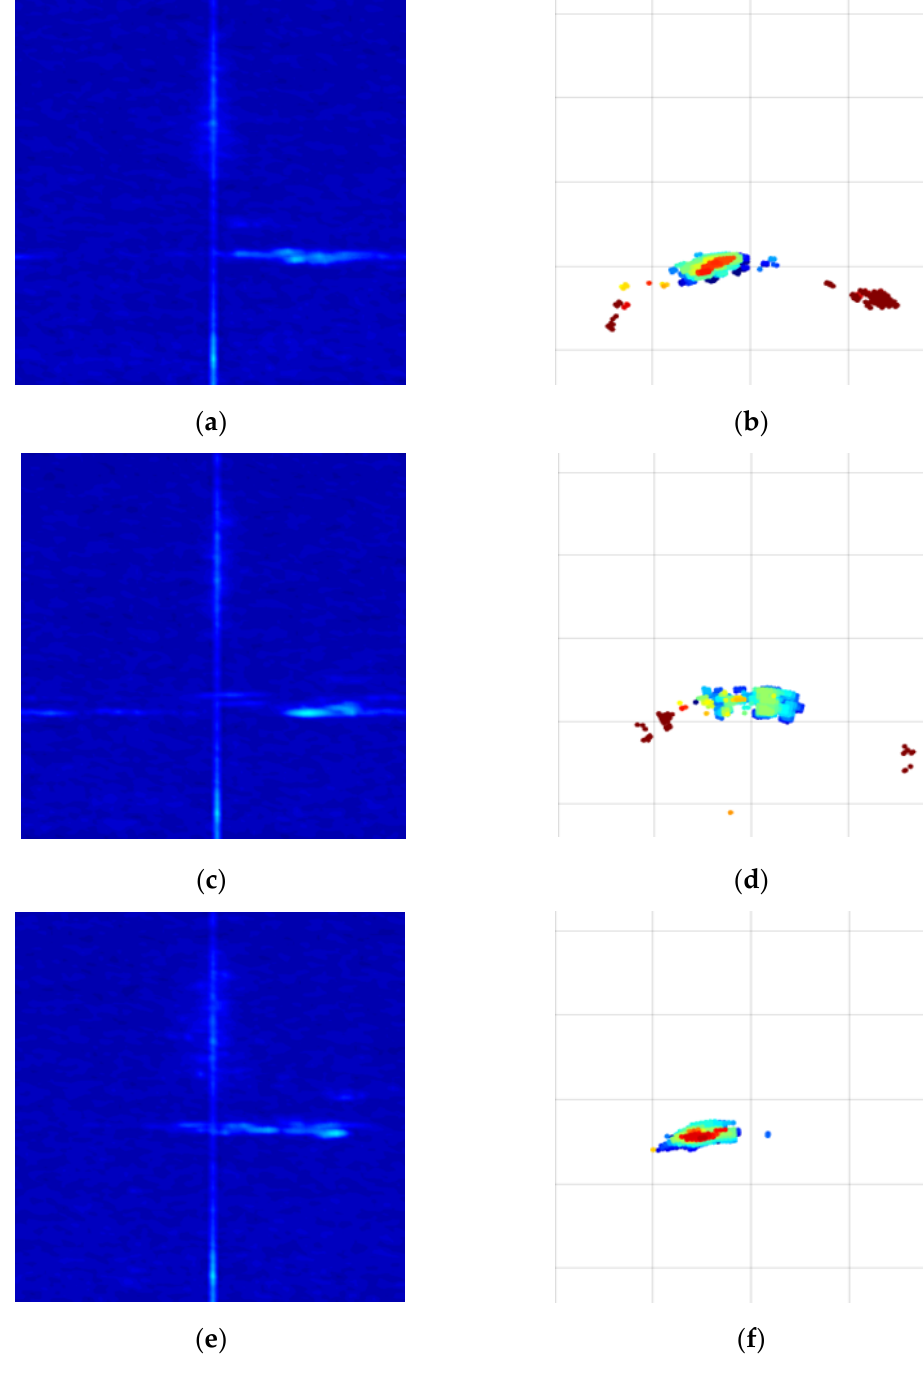
Figure 6. Range–Doppler map and point cloud map when a person moves: ( a ) range–Doppler map when moving diagonally; ( b ) point cloud map when moving diagonally; ( c ) range–Doppler map when moving vertically; ( d ) point cloud map when moving vertically; ( e ) range–Doppler map when moving horizontally; ( f ) point cloud map when moving horizontally.